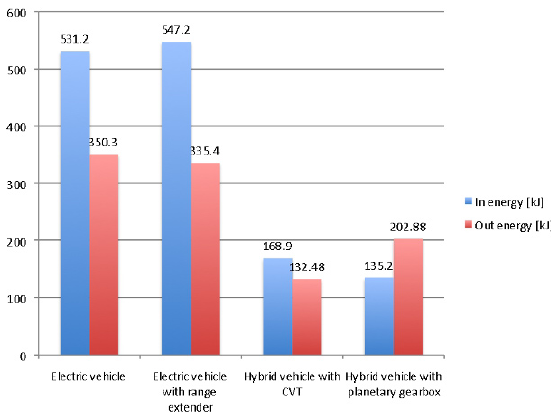
Figure 11. Thecumulatedvalueoftheenergyreachedontheelectric machine on a ECE-15 cycle.